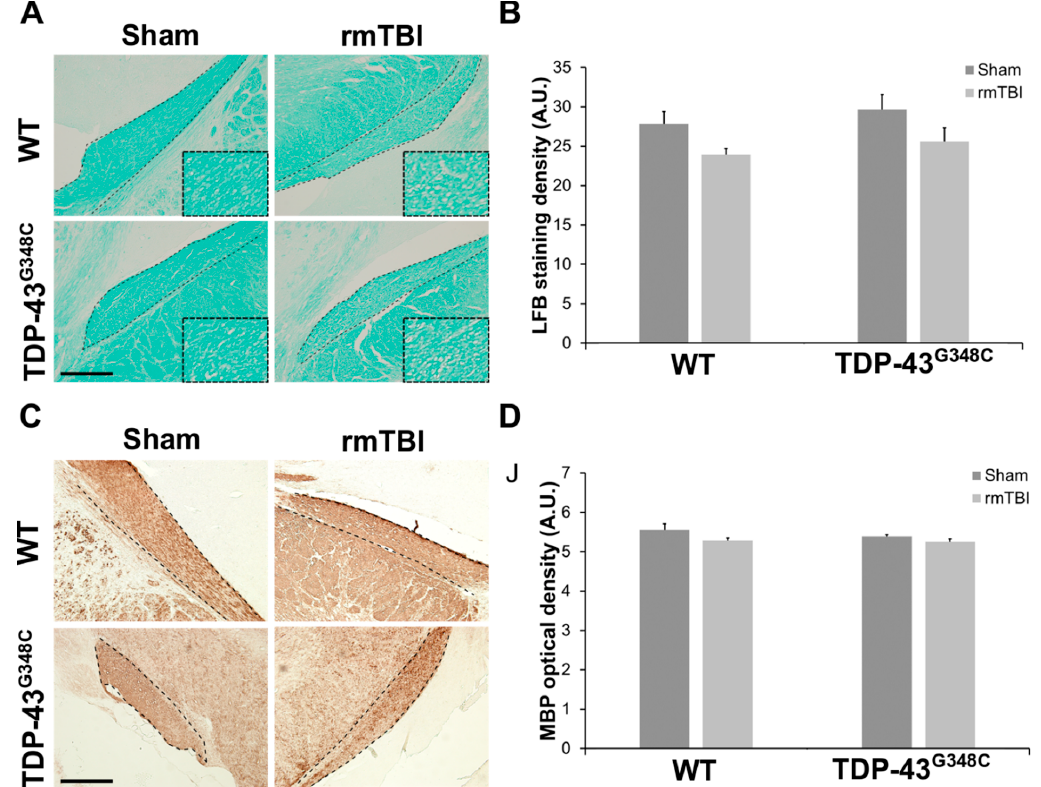
Figure 3. The integrity of myelinated neuronal fibers in the optic tract (OT) of wild ‐ type (WT) and TDP ‐ 43 G348C mice at 6 months after repetitive mild traumatic brain injury (rmTBI). ( A ) Representative microphotographs of the OT stained with luxol fast blue (LFB). Higher magnification of the boxed regions reveals an area with reduced myelin and characterized by porous and weaker LFB staining. Dashed lines indicate the OT. Scale bar: 200 μ m. ( B ) The histogram shows the LFB staining density (AU) in WT and TDP ‐ 43 G348C mice with rmTBI and related control groups (Sham). Results are expressed as means ± SEM ( N = 4–6). ( C ) Representative microphotographs of the OT sections immunostained with anti ‐ myelin basic protein (MBP). Dashed lines indicate the OT. Scale bar: 200 μ m. ( D ) The histogram shows the MBP optical density (AU) in WT and TDP ‐ 43 G348C mice with rmTBI and related control groups (Sham). Results are expressed as means ± SEM ( N = 4–5).